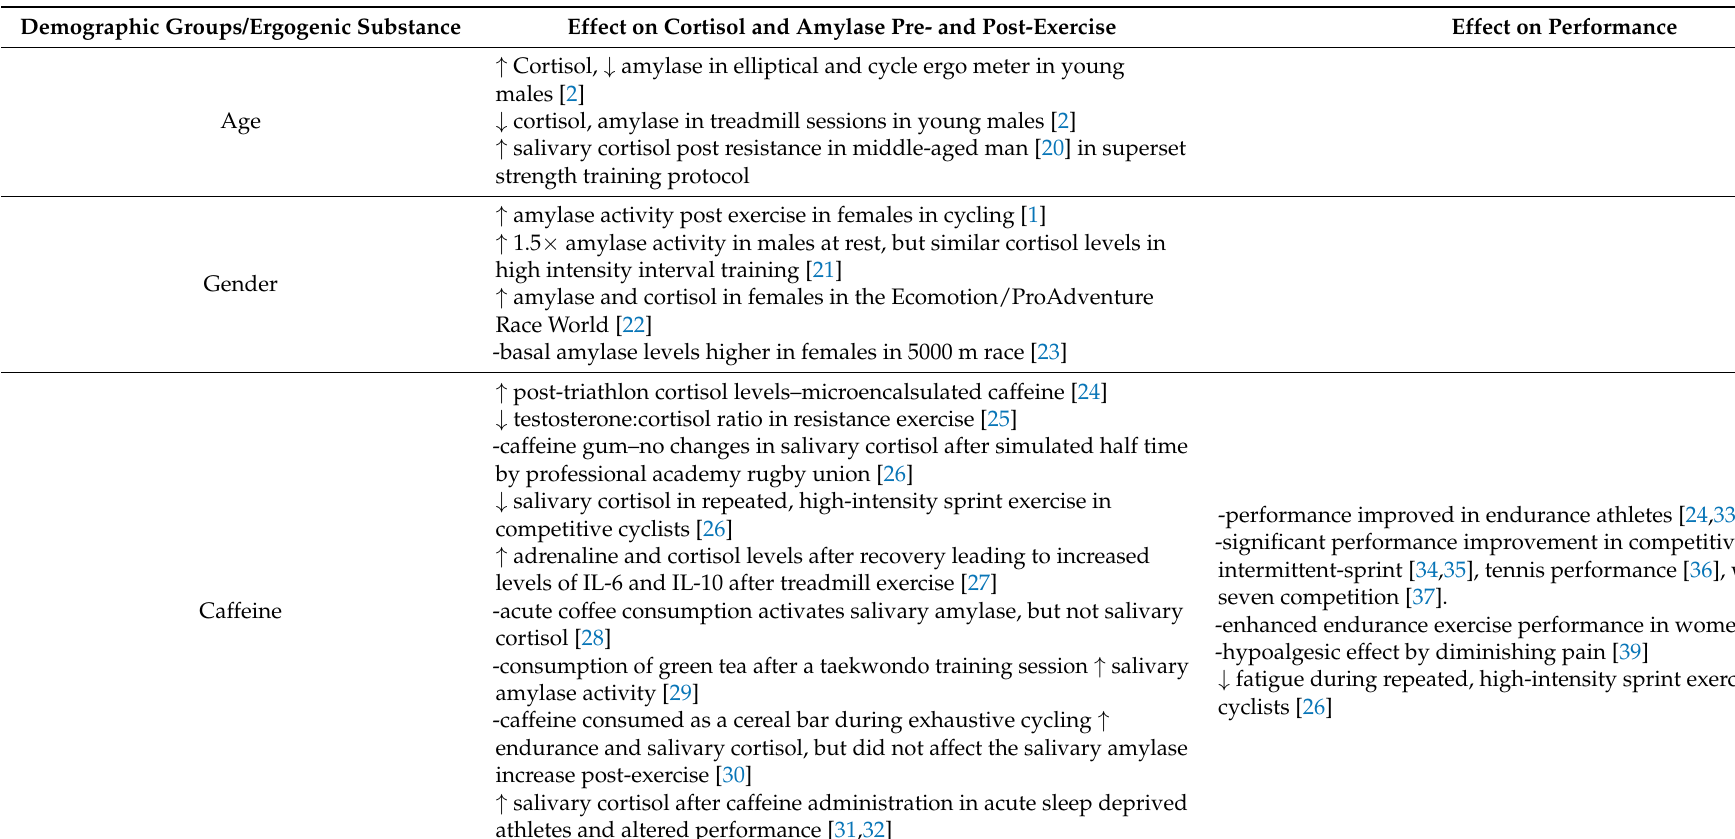
Table 1. Summarized results of the papers included in this